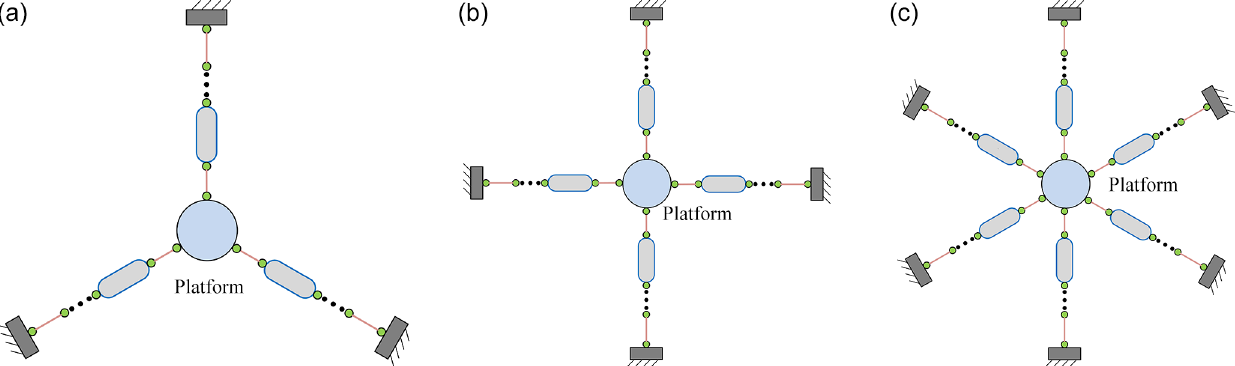
Figure 6. Fundamental forms distributed evenly around the center of the platform: (a) n = 3; (b) n = 4; (c) n = 6.